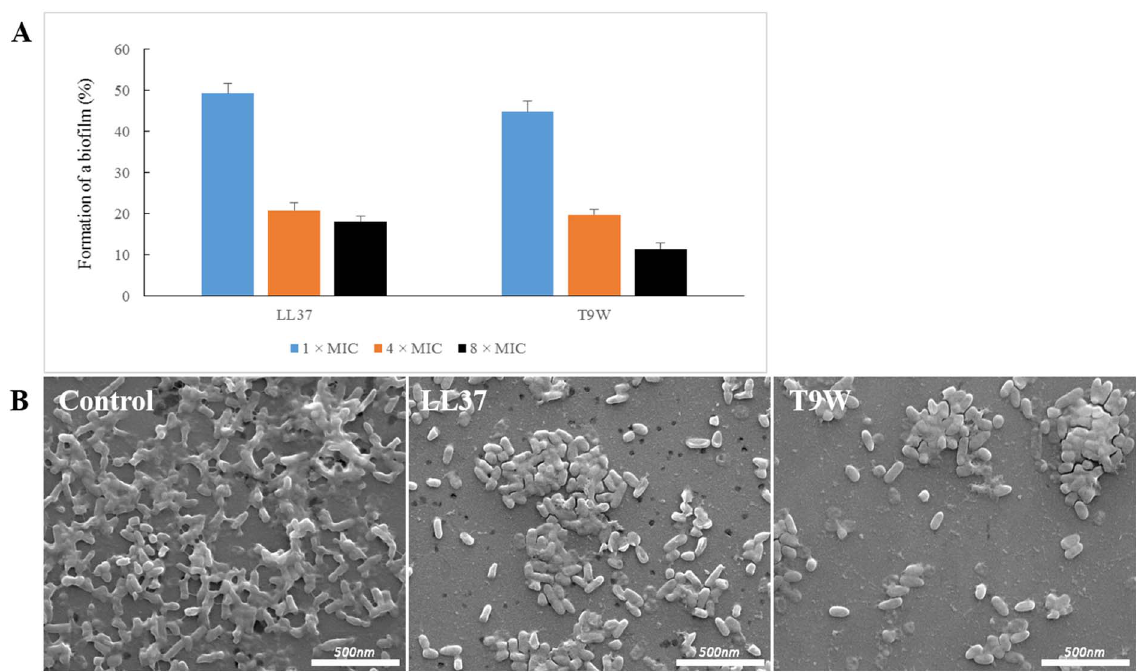
Fig. 6. Antibiofilm activities of the peptides. A) Biomass of P. aeruginosa 27853 biofilms were reduced after 24 h treatment with various concentrations of LL37 and T9W relative to the untreated control. B) FE-SEM images of P. aeruginosa 27853 biofilms treated with the peptides at their 4 6 MICs.